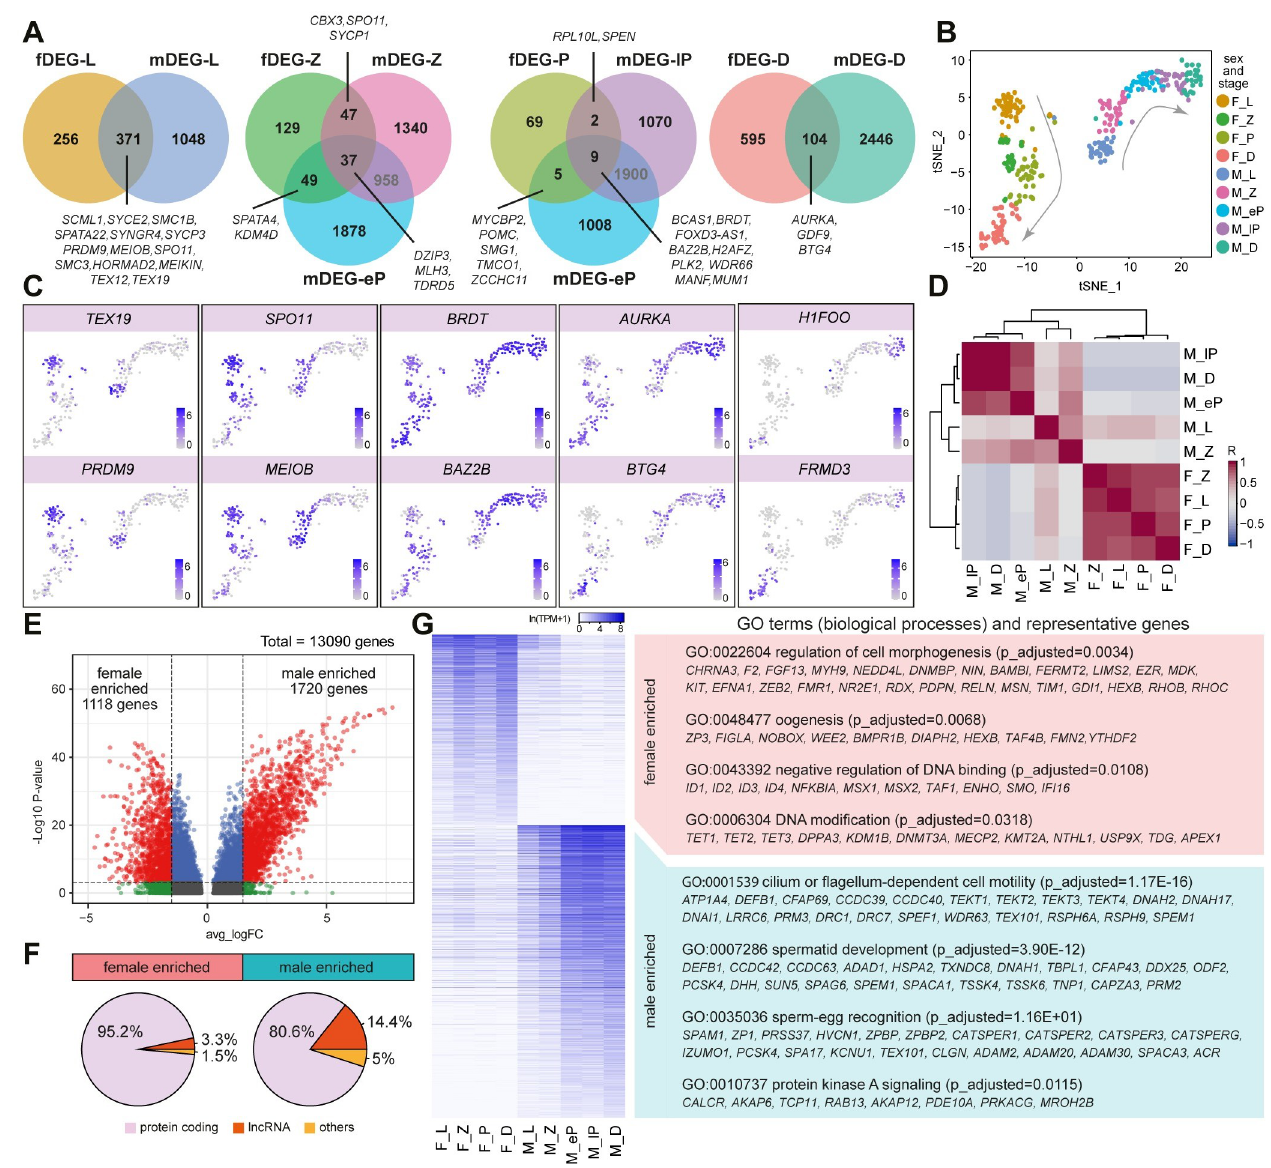
Fig 3. Meiotic differentially expressed genes (DEGs) between females and males. (A) Venn diagrams showing the intersection of fDEGs and mDEGs for each stage during meiotic prophase I (leptotene, L; zygotene, Z; early pachytene, eP; late pachytene, lP and dictyate/diplotene, D). (B-C) tSNE plots of female and male germ cells in meiotic prophase I coloured by sex and stage (B) and showing expression of selected genes/DEGs during meiotic prophase I (C) . F_L, female leptotene; F_Z, female zygotene; F_P, female pachytene; F_D, female dictyate/diplotene; M_L, male leptotene; M_Z, male zygotene; M_eP, male early- pachytene; M_lP, male late-pachytene; M_D, male diplotene. (D) Spearman correlation matrix across stages for both sexes during meiotic prophase I. Colour key is scaled by correlation coefficient R. (E) Volcano plot showing differentially expressed genes between meiotic female and male germ cells. (F) Pie chart showing the percentage of protein-coding, long-non coding (lnc) RNA and other biotypes for female or male enriched genes. (G) Heatmap showing expression of the differentially expressed genes obtained between meiotic female and male germ cells, together with representative GO terms (biological processes) and representative